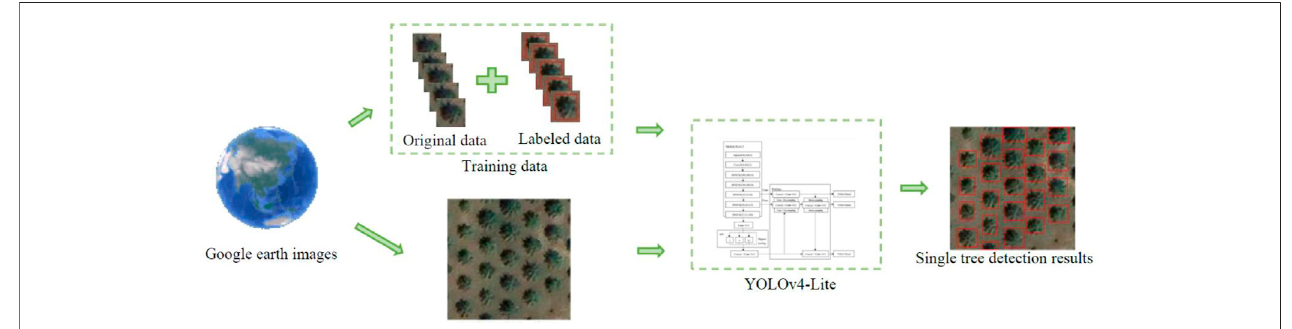
FIGURE 4 | Single tree detection process based on YOLOv4-Lite.